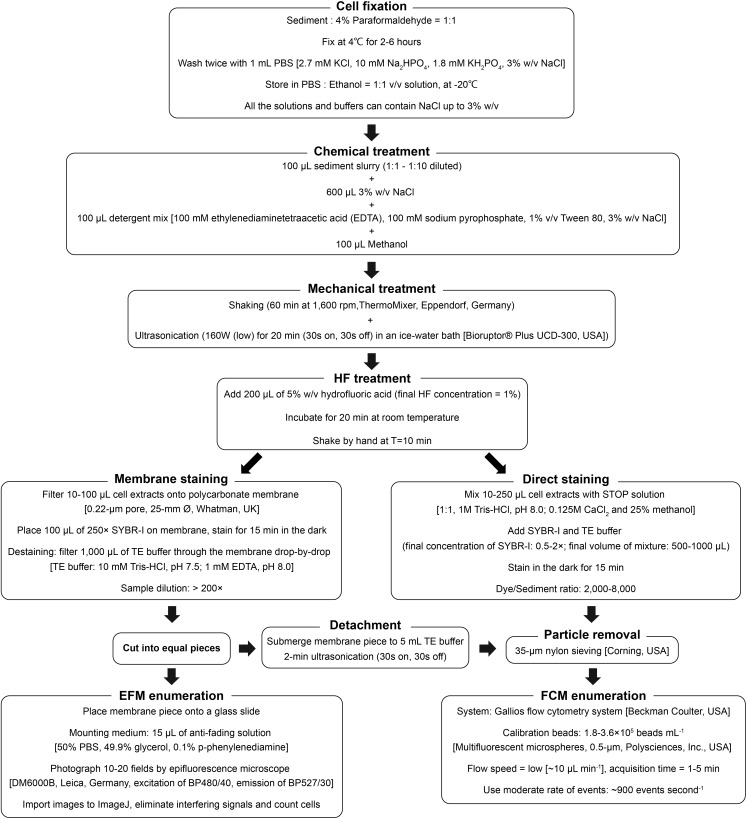
Schematic diagram of the final protocol used for FCM and EFM enumeration of microbial cells in sediment samples.